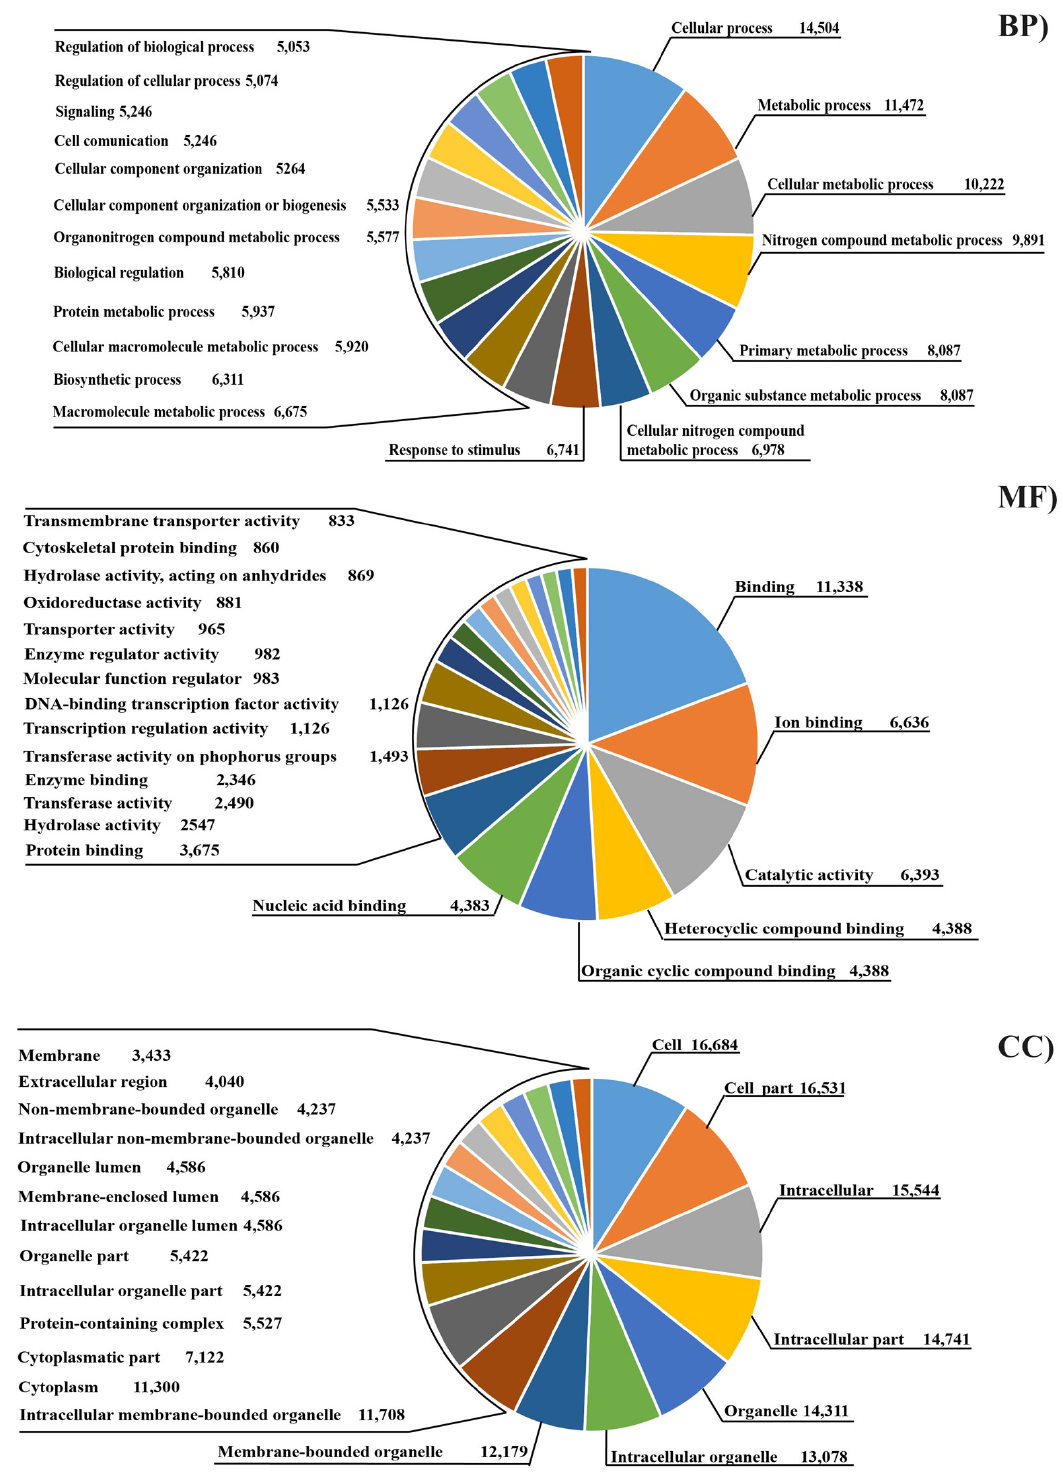
Figure 1. Gene ontology terms distribution for whole expressed genes (RPKM > 1 in at least one library) for control and linseed fed sheep. Cut off was set for the top 20 GO terms. Numbers indicate genes belonging to each GO term.